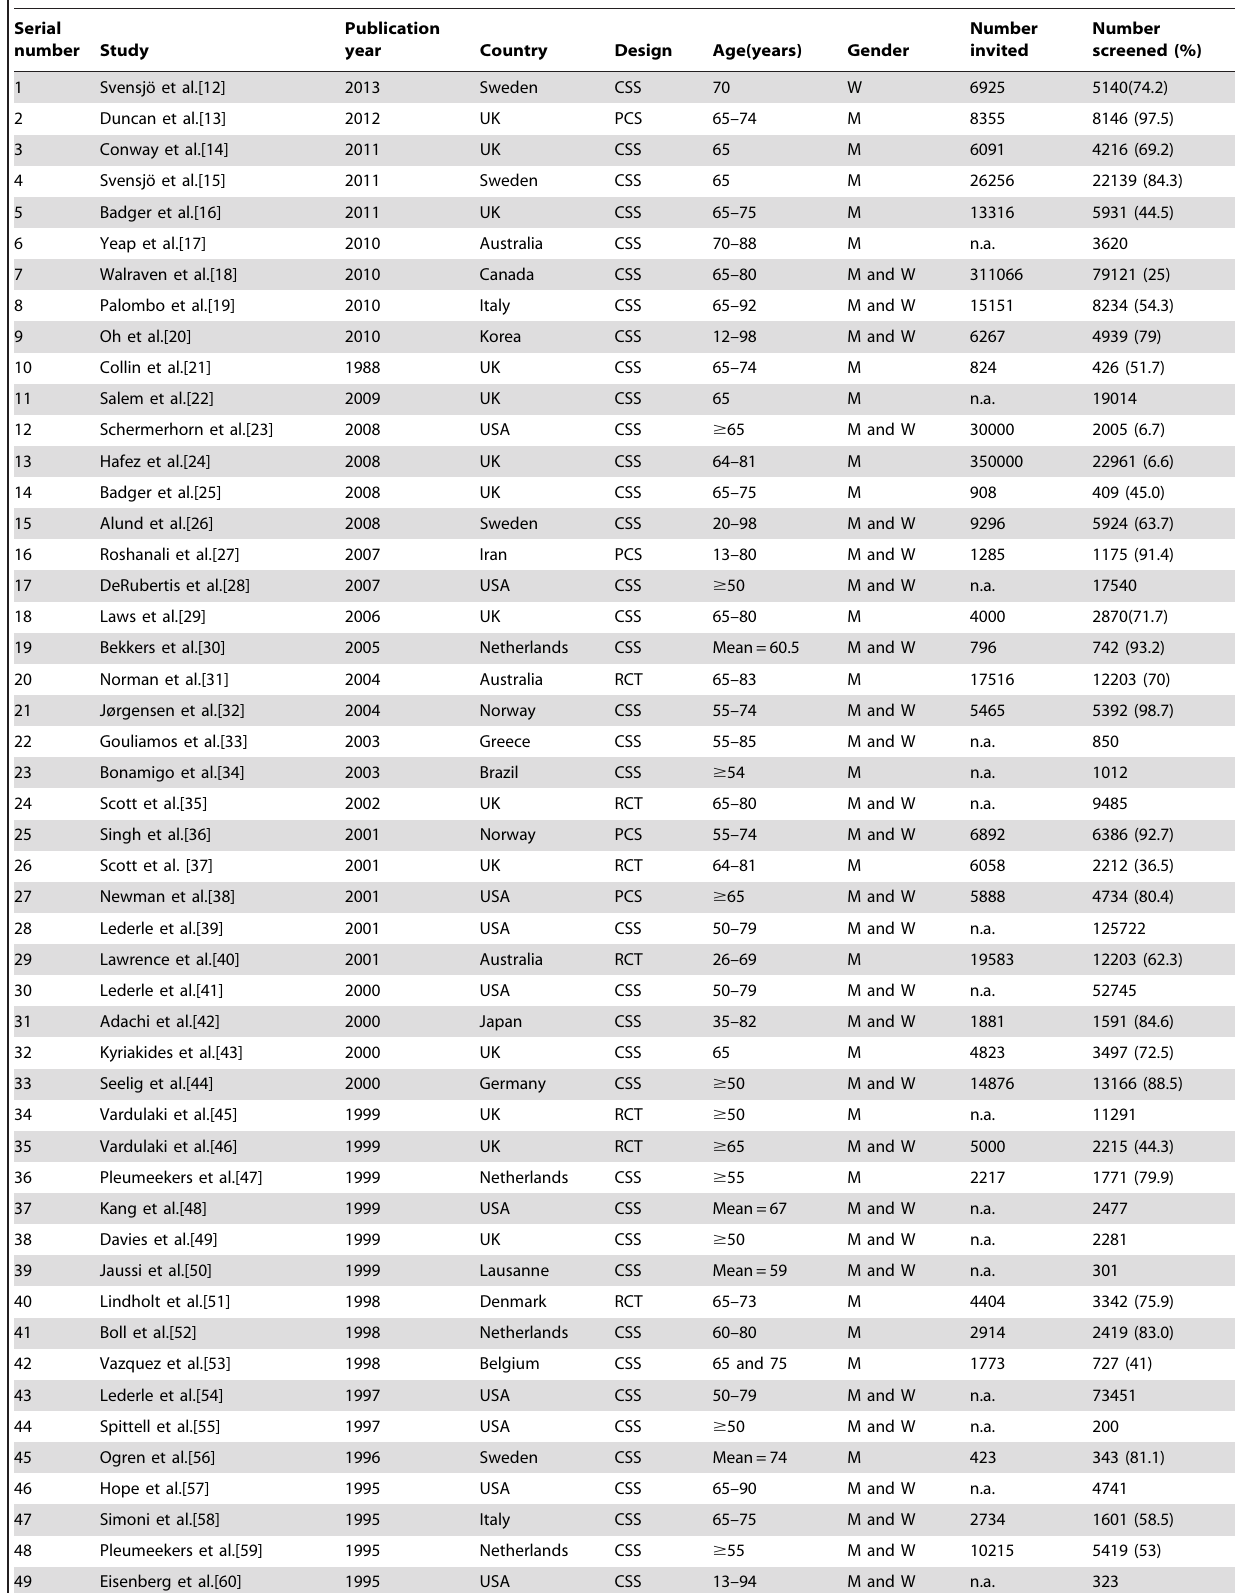
Table 1. Characteristics of population-based studies of abdominal aortic